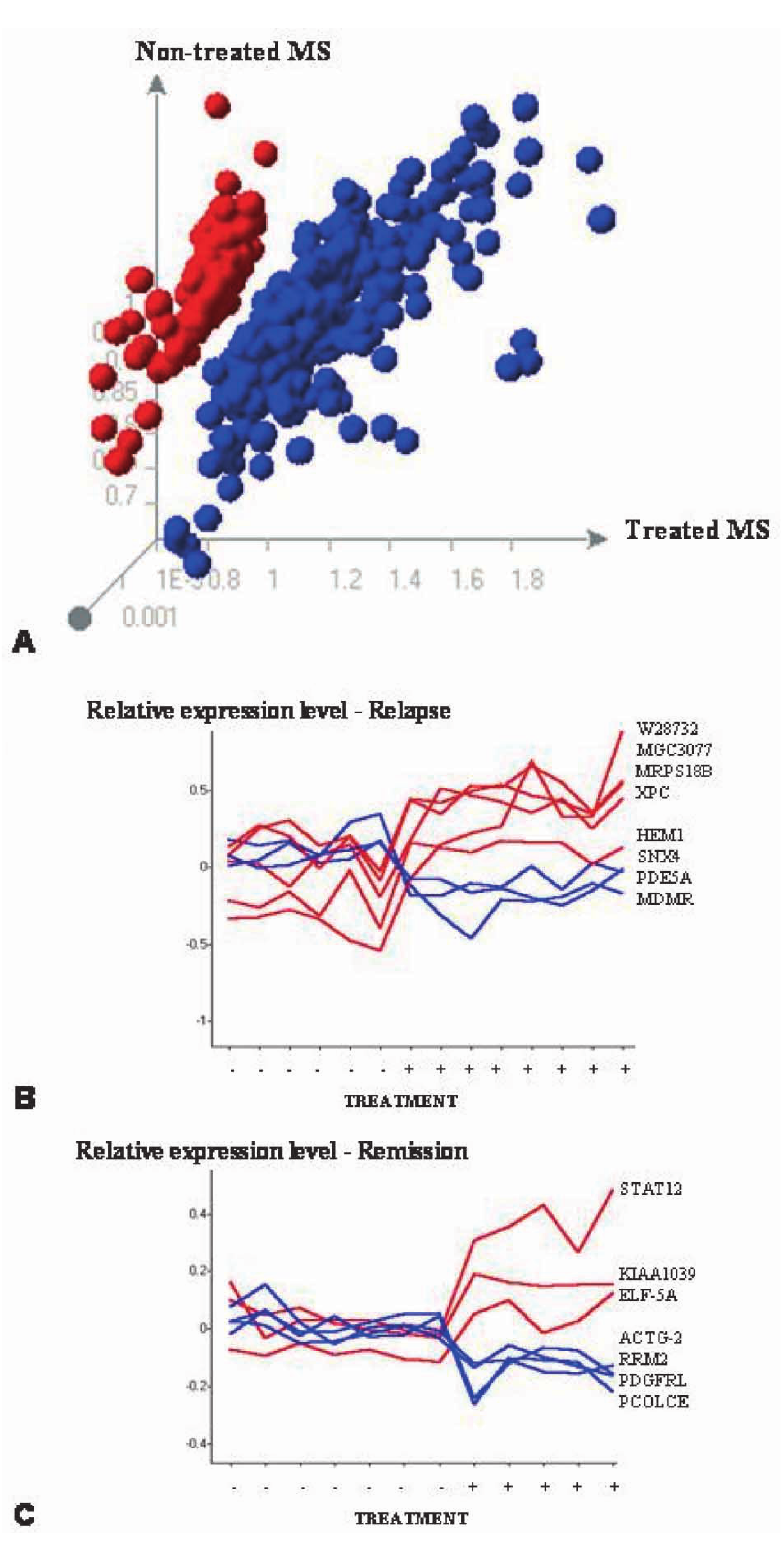
FIGURE 1 Immunomodulatory treatment effect evaluated by gene expression. (A) Three dimensional scatter plot of 535 significant genes ð p , 0 : 05 Þ demonstrating treatment effects in MS patients. y -axis denotes average fold change of each gene in non-treated patients, x -axis denotes average fold change of each gene in treated patients, both in comparison with healthy subjects, z -axis denotes p -value by Info. Red color represents over-expressed genes in untreated patients; blue color represents over-expressed genes in treated patients. (B) Profiles of abundant genes distinguishing treatment effects in MS patients during relapse. (C) Profiles of abundant genes distinguishing treatment effects in MS patients during